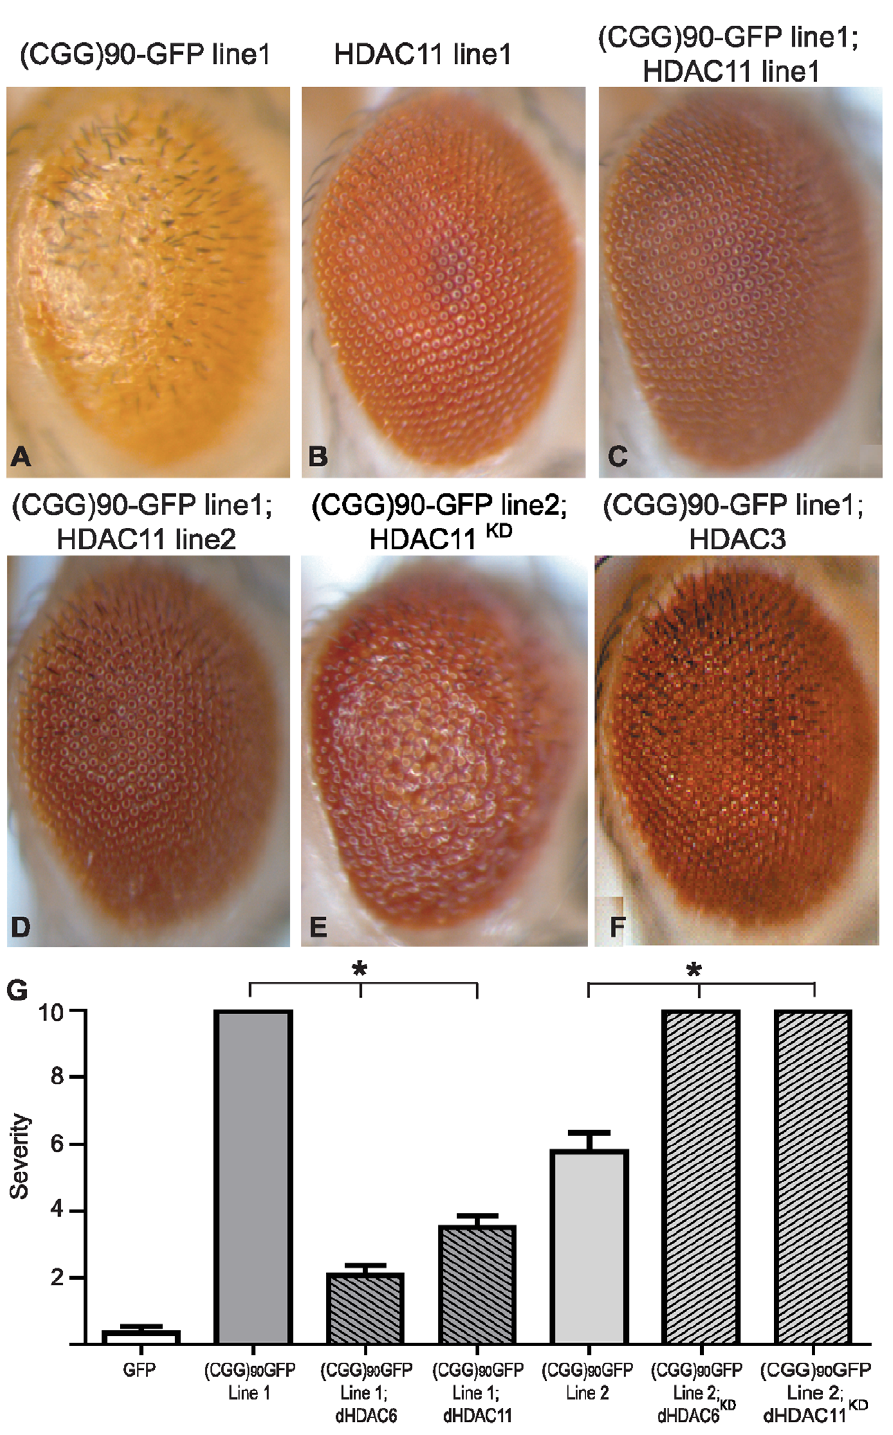
Figure 2. HDAC3 and HDAC11 also suppress (CGG) 90 -eGFP mRNA–induced neurodegeneration. Co-expression of HDAC11, a class IV HDAC and HDAC6 interacting partner, suppresses (CGG) 90 -eGFP induced neurodegeneration similarly to HDAC6 in either of two HDAC11-expressing lines (C and D compared to A). Overexpression of HDAC11 alone had no phenotype (B). Lowering endogenous dHDAC11 by siRNA significantly enhances (CGG) 90 -eGFP induced neurodegeneration (2E versus 1E). Similarly, overexpression of HDAC3, a class I HDAC, suppresses the (CGG) 90 -eGFP phenotype (F). G) Quantitation of the phenotypes in Figure 1 and Figure 2. Analysis of , 20 flies per genotype demonstrates highly significant alterations in the phenotype. * represents P , 0.01 by a Students’ unpaired t-test. The lack of error bars on (CGG) 90 -eGFP line 1 and (CGG) 90 -eGFP line 2 co-expressed with siRNAs against HDAC6 and 11 reflect the fact that all observed flies had the most severe phenotype score.